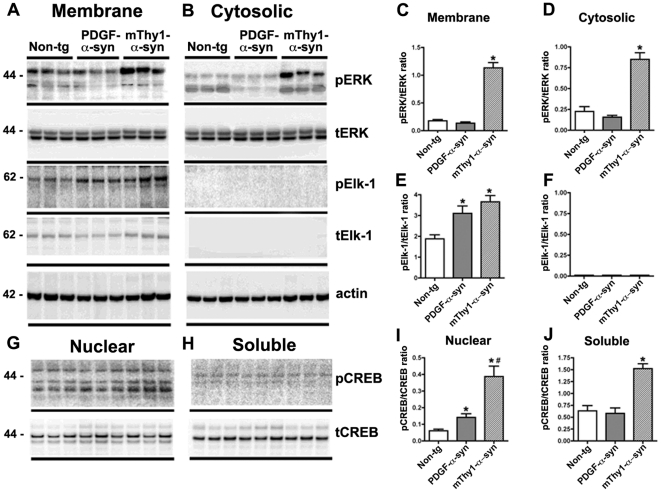
Immunoblot Analysis of ERK, Elk-1 and CREB activity in alpha-syn transgenic mice.(A) Representative immunoblot of phospho-ERK (pERK), total ERK (tERK) phospho-ELK-1 (pELK-1) and total ELK-1 (tELK-1) expression levels in the membrane fraction from the frontal cortex of non-tg, PDGF-alpha-syn and mThy1-alpha-syn tg mice. (B) Representative immunoblot of pERK, tERK, pELK-1 and tELK-1 expression in the cytoplasmic fraction from the frontal cortex of non-tg, PDGF-alpha-syn and mThy1-alpha-syn tg mice. (C) Analysis of ERK activity (pERK/tERK ratio) in the membrane fraction. (D) Analysis of ERK activity (pERK/tERK ratio) in the cytosolic fraction. (E) Analysis of Elk-1 activity (pElk-1/tElk-1 ratio) in the membrane fraction. (F) Analysis of Elk-1 activity (pElk- 1/tElk-1 ratio) in the cytosolic fraction. (G) Representative immunoblot of phospho- CREB (pCREB) and total CREB (tCREB) in the nuclear fraction from the frontal cortex of non-tg, PDGF-alpha-syn and mThy1-alpha-syn tg mice. (H) Representative immunoblot of pCREB and tCREB in the soluble fraction from the frontal cortex of non-tg, PDGF-alpha-syn and mThy1-alpha-syn tg mice. (I) Analysis of CREB activity in the nuclear fraction. (J) Analysis of CREB activity in the soluble fraction. * Indicates a significant difference between alpha-syn tg mice and non-tg controls p<0.05, one-way ANOVA and post hoc Fisher). # Indicates a significant difference between PDGF-alpha-syn and mThy1-alpha-syn tg mice (p<0.05, one-way ANOVA and post hoc Fisher)(n = 8 mice per group).